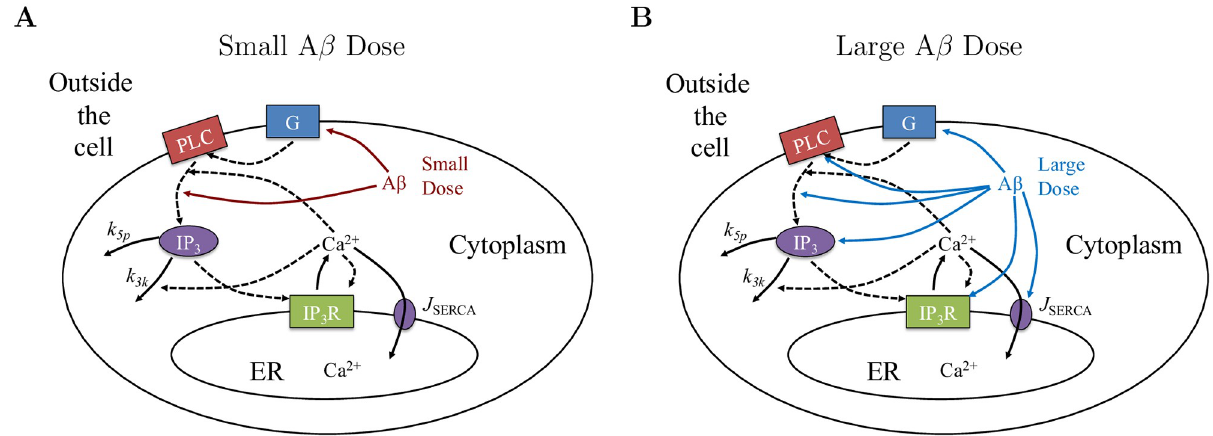
Fig 2. Model structure and components. Modeling assumptions for the location of impact of A β on the production of IP 3 with key Ca 2+ signaling mechanisms included in the closed-cell model. The key model assumptions for how A β impacts the IP 3 signaling cascade are illustrated as red arrows for “small” doses in A . The impacted cellular mechanisms for “large” doses of A β are highlighted by the blue arrows in B .